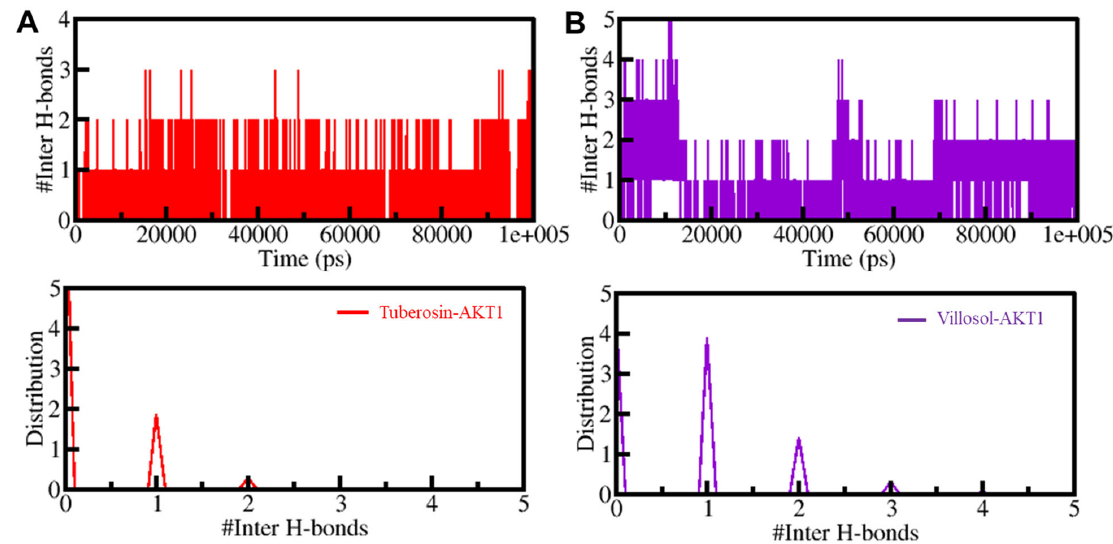
Figure 6. The time evolution of intermolecular hydrogen bonds formed within 0.35 nm between AKT1 and tuberosin ( A ) and villosol ( B ). The panels on the lower side depict the probability density function distribution of H ‐ bonds.